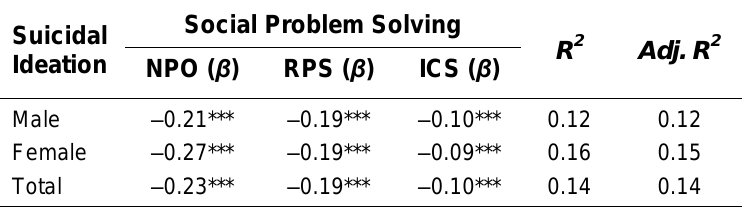
Prediction of Adolescent Suicidal Ideation from Social Problem